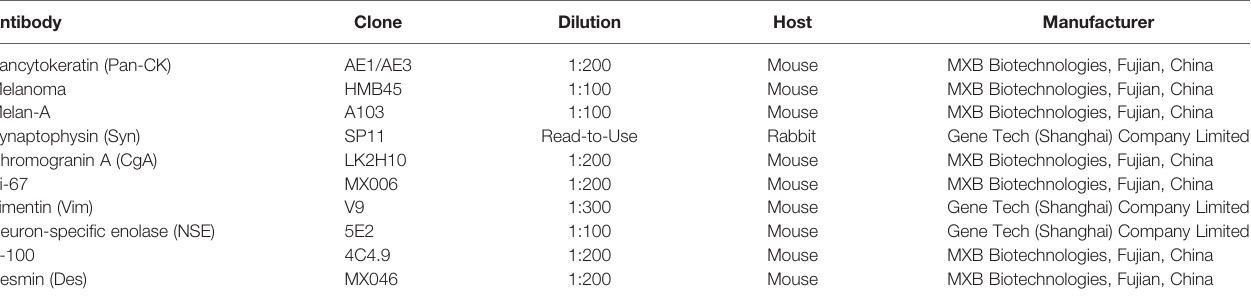
Mouse Gene Tech (Shanghai) Company Limited S-100 1:200 Mouse MXB Biotechnologies, Fujian, China Desmin (Des) 1:200 Mouse MXB Biotechnologies, Fujian,